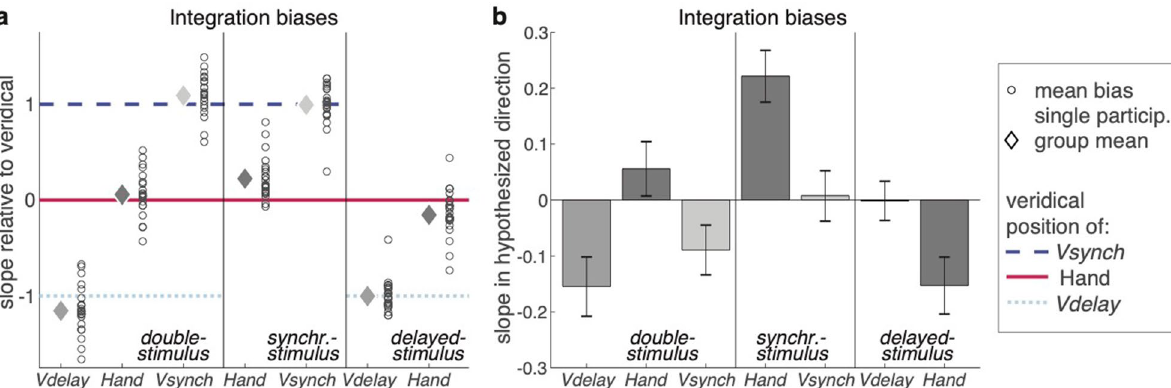
Figure 3. Integration biases in Experiment 2. ( a ) Integration biases (i.e., slopes of the regression analyses) relative to the veridical positions of the hand endpoints (solid red line), of Vdelay (dotted light blue line), and of Vsynch (broken blue line) for double-stimulus, synchronous-stimulus, and delayed-stimulus trials. The open circles illustrate individual participants’ bias in the respective trials; the diamonds illustrate the group mean. ( b ) The average integration biases (mean ± SEM) in the hypothesized directions: hand endpoint towards Vsynch, Vsynch and Vdelay towards the hand endpoint. For the delayed-stimulus trials this means that the negative bias of the hand-position judgments indicates a bias away from the invisible Vsynch and towards the visible Vdelay position towards Vsynch was significant ( t (21) = 4.68, d z = 0.998, p < 0.001), and in delayed-stimulus trials, the bias was negative and significant ( t (21) = 2.93, d z = 0.624, p = 0.008), hence away from the position of (the not